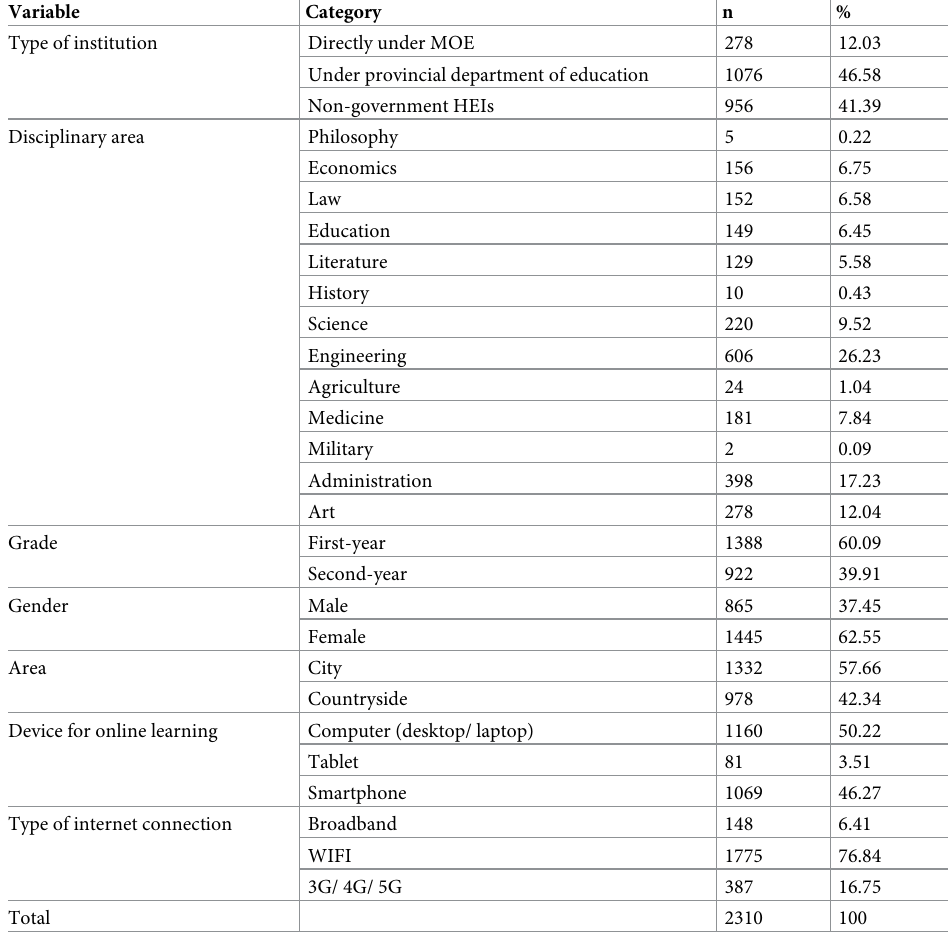
Table 1. Demographics for student